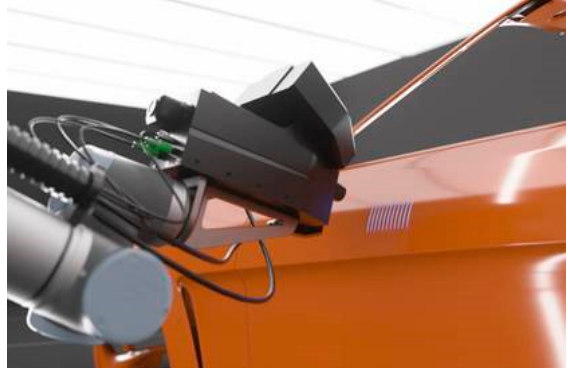
Figure 12. Implementation of a THz TDS in an industrial setting. Courtesy of Helmut Fischer GmbH.